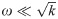
The PC model shows unrealistically high jitter when tracking stimuli.(a) Tracking a stimulus with f(0) = 0.1, A21(0) = −1, initial velocity v1(0) = −1, v2(0) = −0.5. Jitter amplitude is about 5-fold higher than observed in Fig 1a. (b) at high stimulus frequency (not obeying ω≪k), f(0) = 2, A21(0) = 1.5, v1(0) = 0.5, v2(0) = −0.5, jitter increases to an amplitude to be almost 4 times higher than the stimulus and 20-fold higher than observed in Fig 1a. Such phenomena occur for a wide range of parameters. Here we used k = 8, g = 0.3 and initial amplitudes A1n(0) = 0. (c) When stimulus suddenly stops, PC model does not settle to zero velocity. Here we use three periods in the predictor, and f(0) = 0.1, A21(0) = −1, v1(0) = 0.5, v2(0) = −0.5 and all other initial amplitudes Ain(0) = 0.